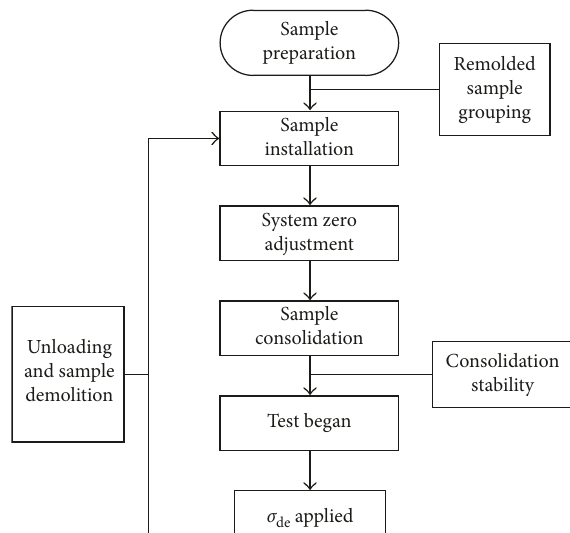
d , versus cycle number, N (no. 8